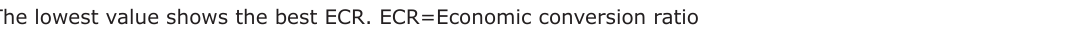
Table-4: Economic efficiency of dietary monosodium glutamate supplementation.